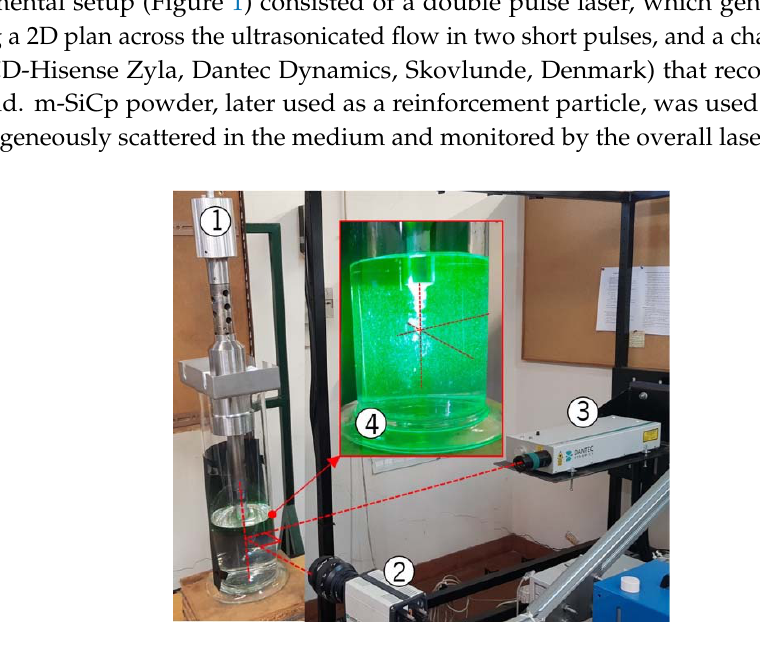
Figure 1. Particle image velocimetry (PIV): (1) US MMM transducer; (2) CCD camera, Hisense Zyla; (3) Double pulse laser; (4) illuminated water with m-SiCp tracer particles.